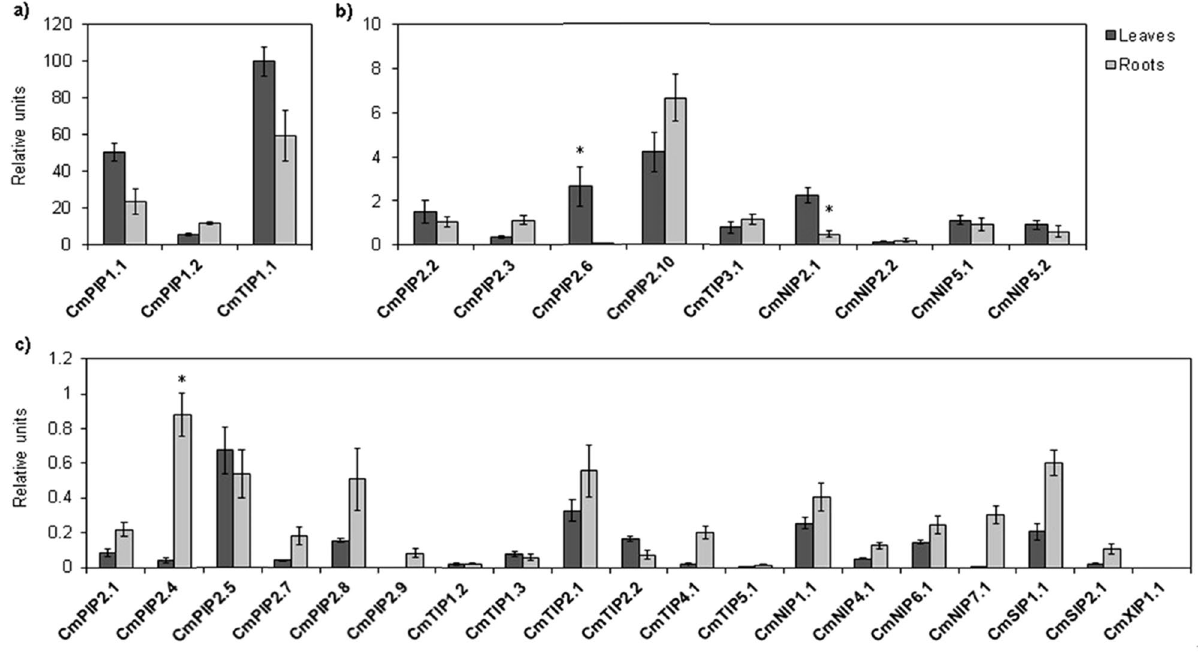
Figure 4. Expression levels of aquaporins genes. All the analyses were performed using qPCR, for leaves and roots. Statistical analysis was performed using SPSS 25.0.0.1. The values are the means ± s.e.m. of 3 to 6 biological replicates. Columns with * differ significantly according to Tukey’s test ( p = 0.05). Each group is formed by aquaporins genes with similar expression levels represented as relative units (ru) ( a ) Group 1 (10–100 ru): PIP1;1, PIP1;2 and TIP1;1 ( b ) Group 2 (1–10 ru): PIP2;2, PIP2;3, PIP2;6, PIP2;10, TIP3;1, NIP2;1, NIP2;2, NIP5;1 and NIP5;2 ( c ) Group 3 (0–1 ru): PIP2;1, PIP2;4, PIP2;5, PIP2;7, PIP2;8, PIP2;9, TIP1;2, TIP1;3, TIP2;1, TIP2;2, TIP4;1, TIP5;1 NIP1;1, NIP4;1, NIP6;1, NIP7;1, SIP1;1 , SIP1;2 and XIP1;1. This figure was made using Microsoft Office 2016